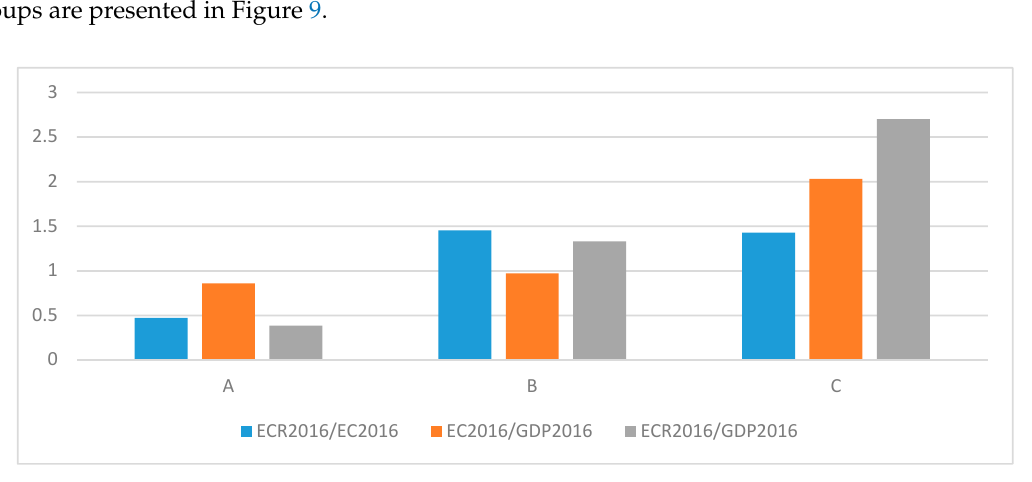
Figure 9. Comparison of group averages for IRE in 2016.